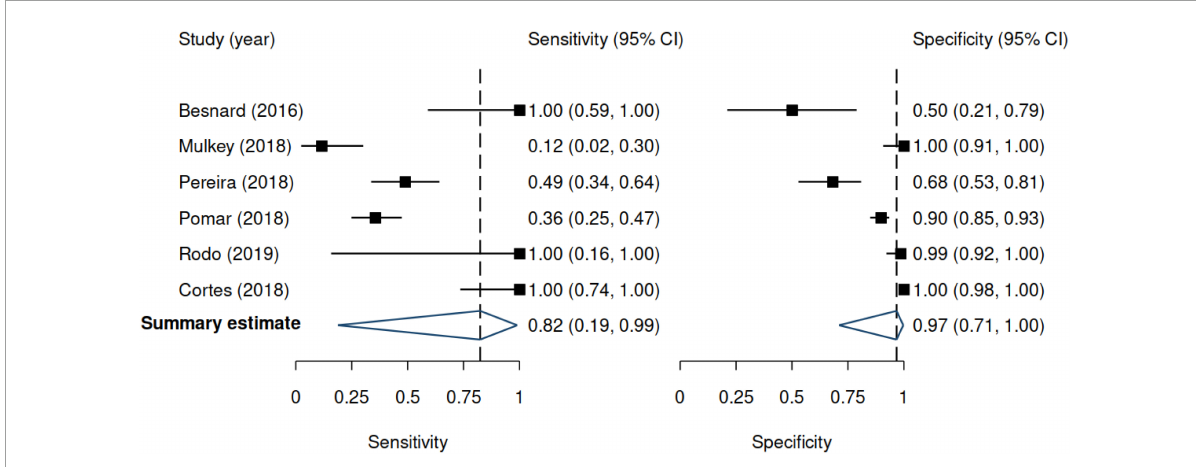
FIGURE3 Forest plots for sensitivity and specificity. Results are based on the random-effects model. 95% CI denotes 95% confidence interval. The positive likelihood ratio was 24.9 (95% CI 2.11–293.2), and the negative likelihood ratio was 0.19 (95% CI 0.02–2.05).